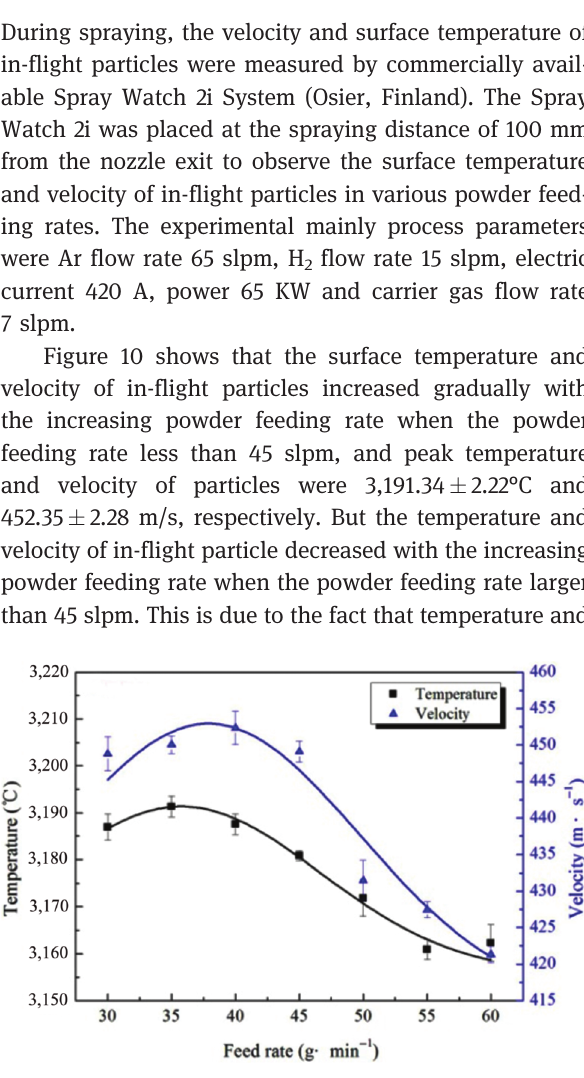
Figure 10: Effect of YSZ powder feeding rate on in-flight particles temperature and velocity at spraying distance of 100